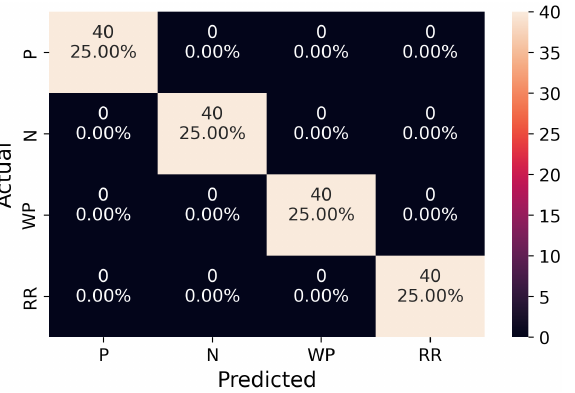
Figure 5. Confusion matrix obtained for multi-input MobileNetV2 model on 160 (patient) test samples. The upper number in each entry of the matrix is the total number that the model predicts for the corresponding classes, and the bottom number is the percentage, which refers to the total number of test samples.